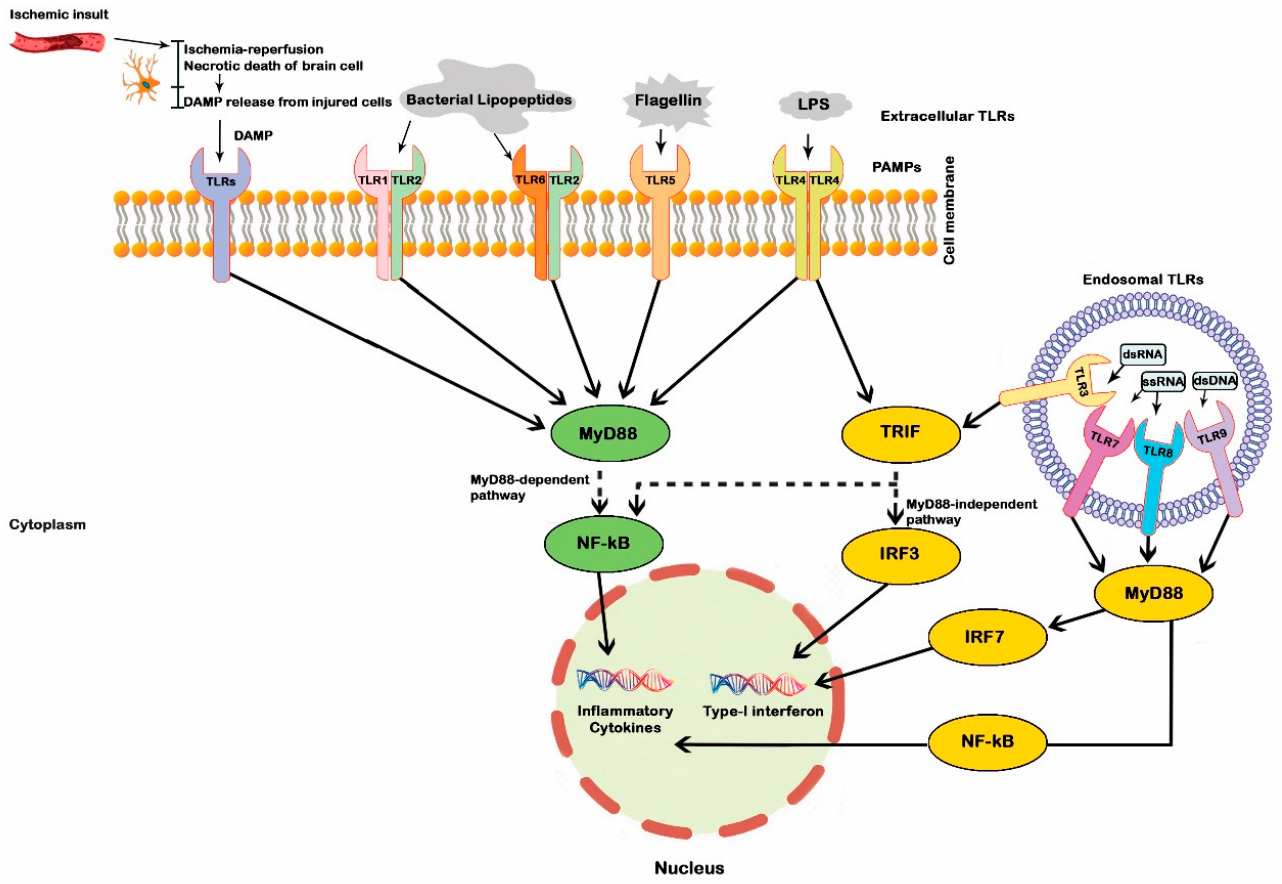
Figure 1. Diagrammatic representation of the Toll-like receptor (TLRs) signaling pathways. TLRs are expressed in neurons, microglia, astrocytes, oligodendrocytes as well as neural stem cells. DAMPs: Damage-associated molecular patterns; LPS: Lipopolysaccharide; dsDNA: Double-stranded DNA; dsRNA, Double-stranded RNA; ssRNA: Single-stranded RNA; MyD88: Myeloid differentiation primary response 88; PAMPs: Pathogen-associated molecular patterns; NF-kB: nuclear factor kappa B; IRF: Interferon regulatory factor; TRIF: TIR-domain-containing adapter inducing IFN- β .